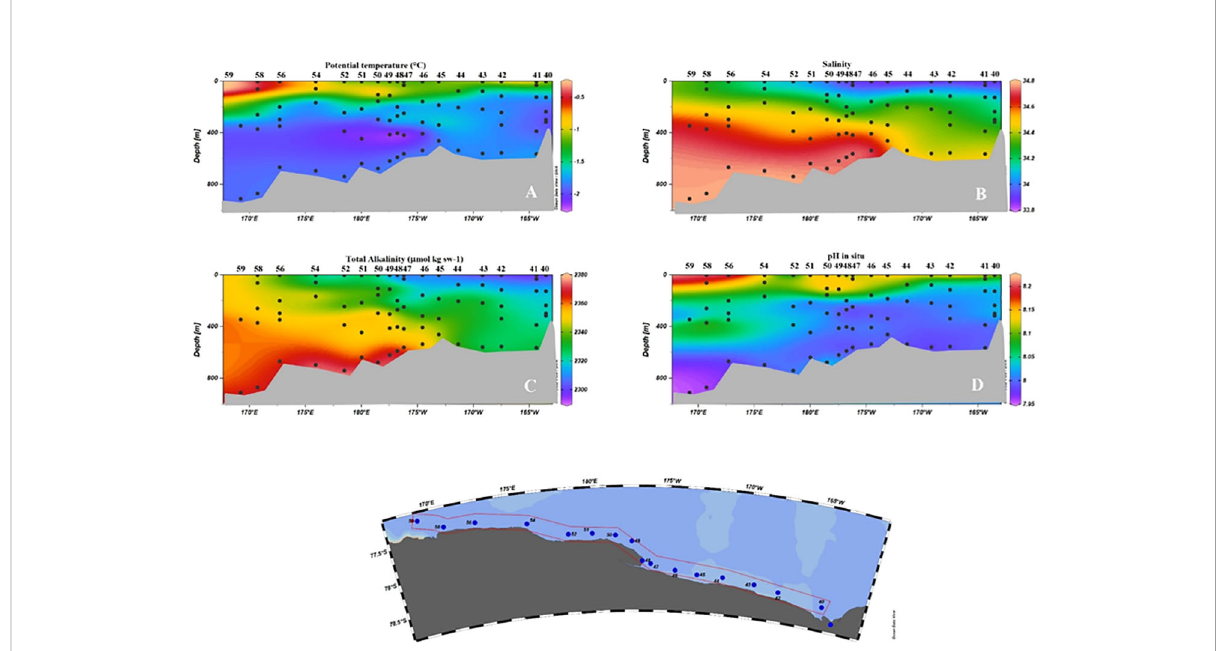
FIGURE 9 Vertical distribution of physical and chemical properties along the RIS. (A) Potential temperature (°C); (B) Salinity (C) A T (µmol kg sw -1 ); (D) pH in situ